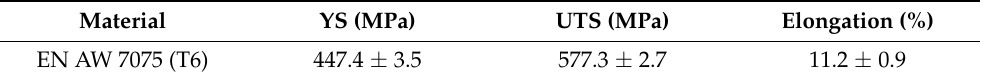
Table 2. Tensile properties of as-received material; standard deviations are reported in the